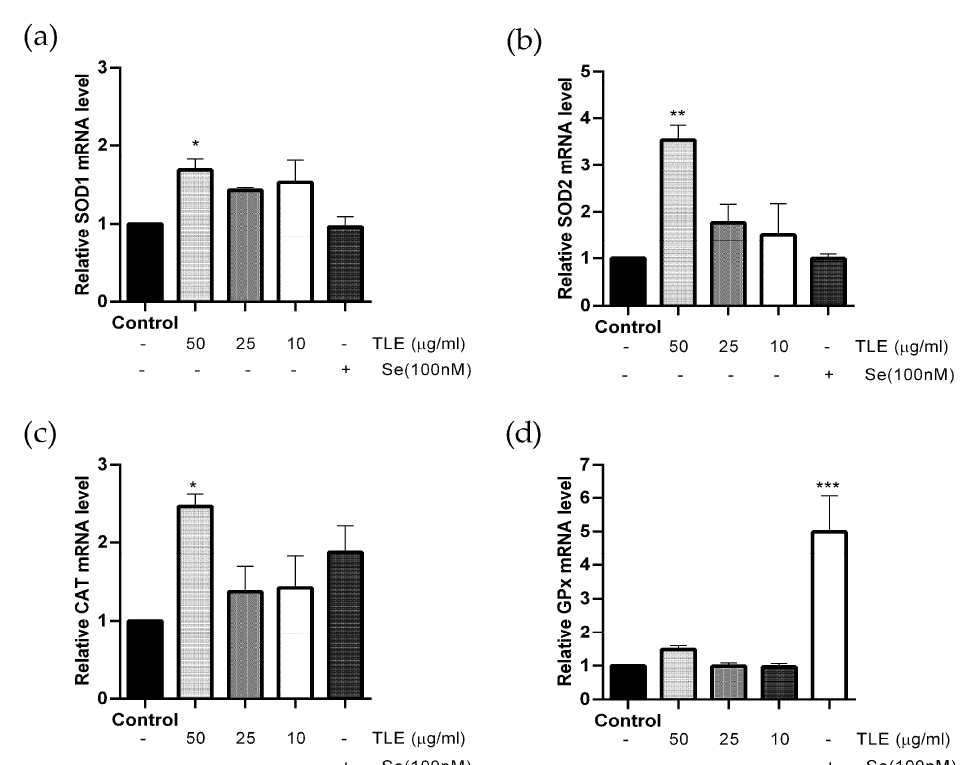
Figure 4. TLE increases the mRNA expression of antioxidant enzyme genes. HT-22 cells (passage 13,15,16) were treated with TLE (10-50 µ g/mL) for 12 h and then analyzed with the real-time PCR technique. The mRNA expression levels of ( a ) SOD1, ( b ) SOD2, ( c ) CAT and ( d ) GPx were normalized with β -actin and the results are shown as fold change in mRNA expression with mean SEM ( n = 3). * p value < 0.05, ** p value < 0.01, *** p value < 0.005 compared with untreated control. ±